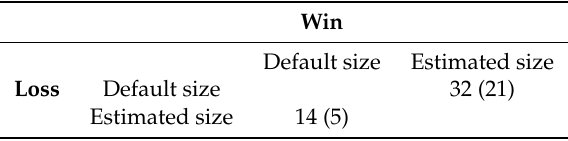
Table 3. Summary of test accuracy